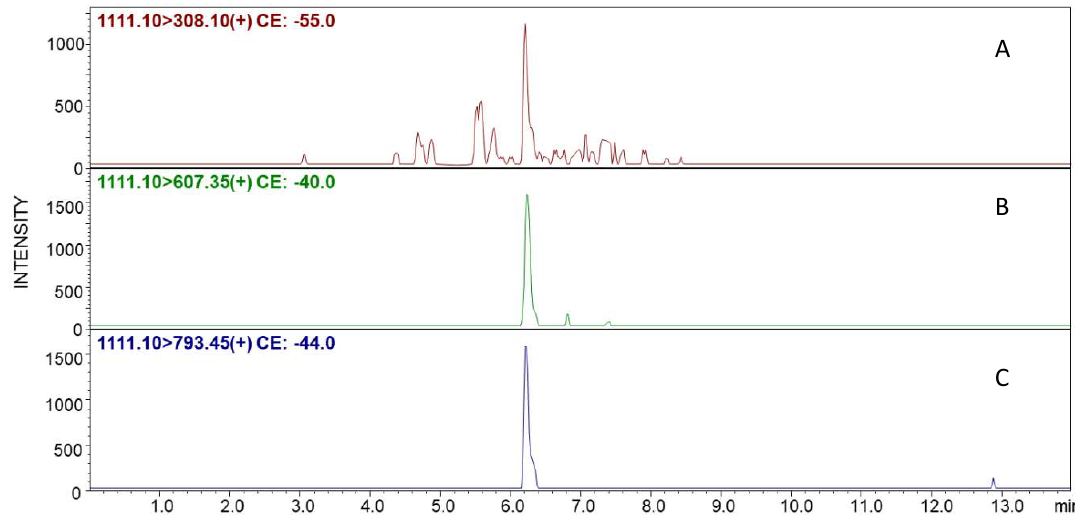
Figure 5. Multiple reaction monitoring (MRM) chromatograms obtained after analysis of podocyte tryptic digest for the following transitions: ( A ) 1111.10 → 308.10 m / z ([TPP + H] + ), ( B ) 1111.10 → 607.35 m / z (y 3 ), and ( C ) 1111.10 → 793.45 m / z (y 4 ), corresponding to the fragment ions of peptide conjugated